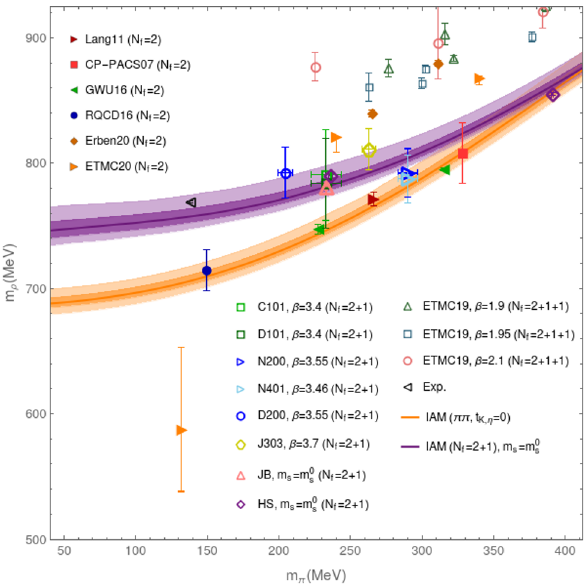
Figure 41 . Result for the (cid:26) meson mass obtained in the N f = 2 + 1 data analysis done here with the one quoted in the lattice papers for N f = 2 and 2 + 1 + 1 simulations.